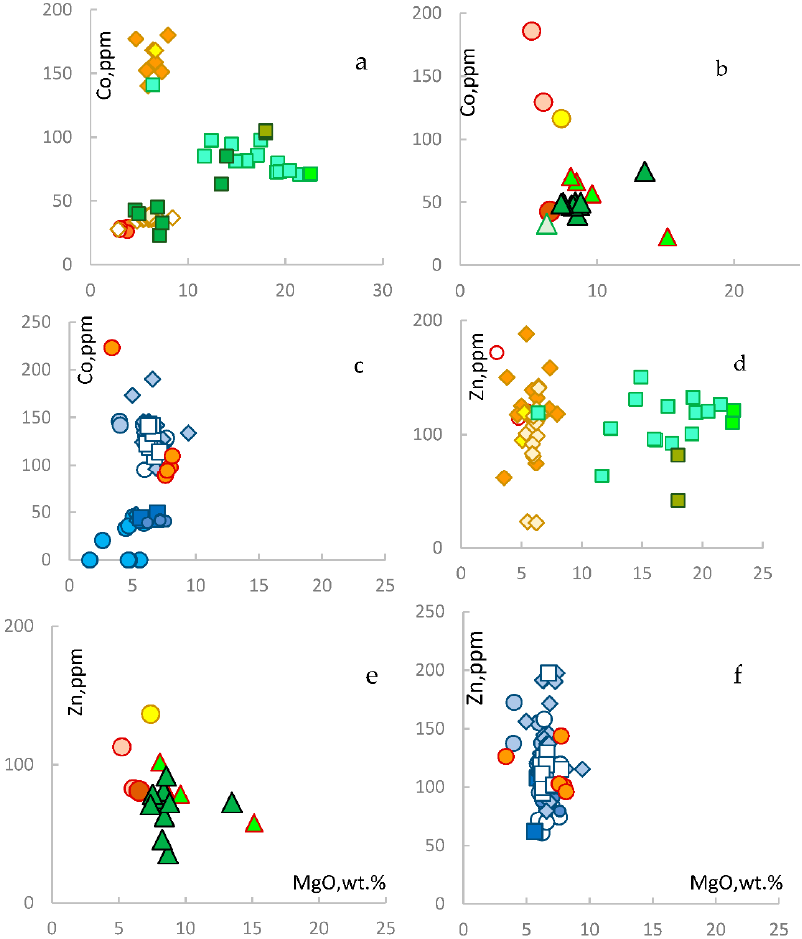
Figure 19. Diagrams MgO vs. Co ( a – c ) and Zn ( d – f ) for volcanic rocks. Captions in Figure 18.